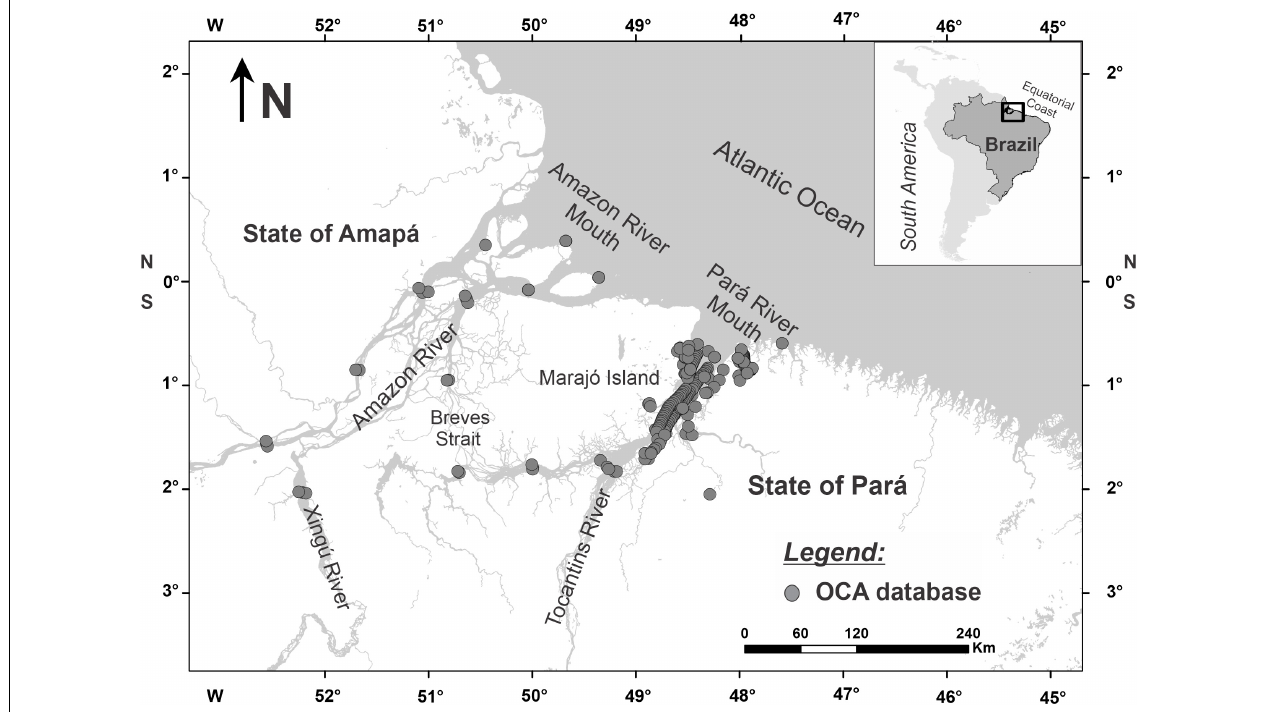
FIGURE 4 | Sampling stations of the Amazon Coastal